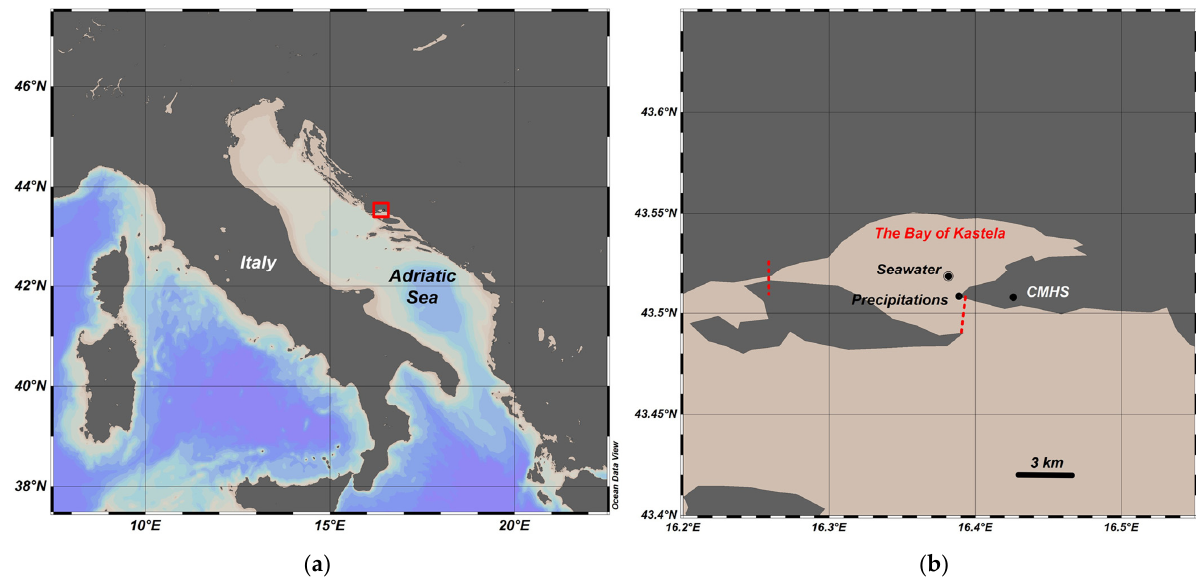
Figure 1. ( a ) Locations of the sampling stations in the Central Adriatic Sea marked with a red square; ( b ) the enlarged part of a map marked with a red square on the left panel. ‘Seawater’ label indicates the sampling location ST101 where seawater was sampled. ‘Precipitation’ label indicates the location of the Institute of Oceanography and Fisheries where precipitation samples for Hg analysis were collected. ‘CMHS’ label represents the location of the Croatian Meteorological and Hydrological Service station where official data on the amount of precipitation and wind speed and direction were determined. Marine borders of the Bay of Kaštela are indicated with red dotted lines. Maps were created using Ocean Data View [32].